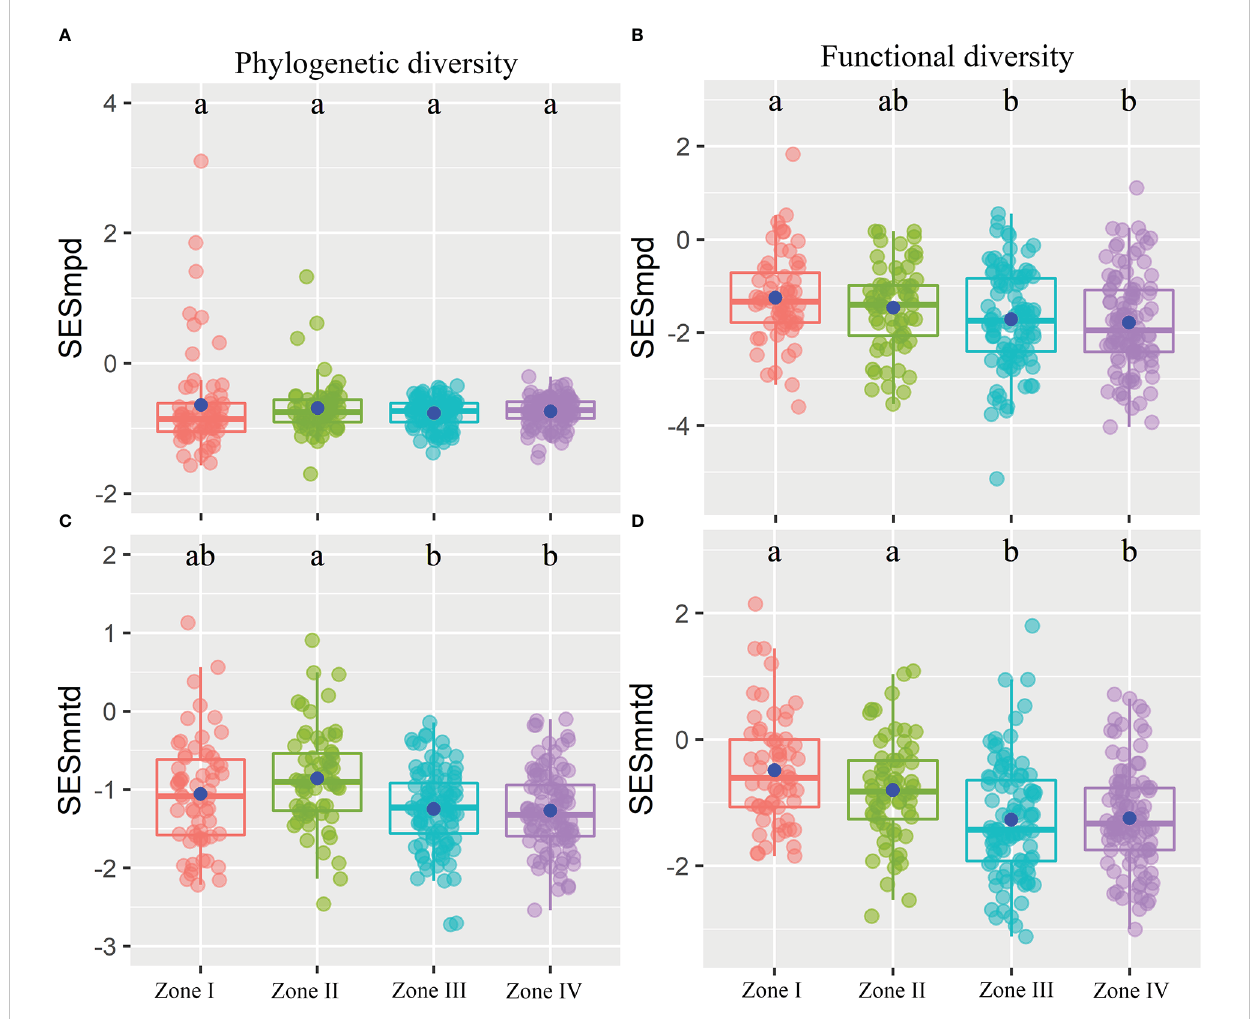
FIGURE 4 The standardized phylogenetic (A, C) and functional (B, D) structures of plant communities within the reservoir riparian zone regulated by the Three Gorges Dam in China. Boxes present the median, 25th, and 75th percentile. The blue dots of boxes represent the average values. Different letters are used to mark signi fi cantly distinct values between inundation gradients based on the Kruskal-Wallis test (p <